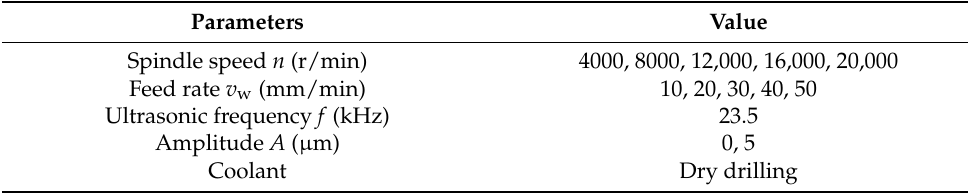
Figure 3. Photo of the machining center: ( a ) overall experimental setup, ( b ) features of RUAD. Table 2. Experimental parameters of rotary ultrasonic dry